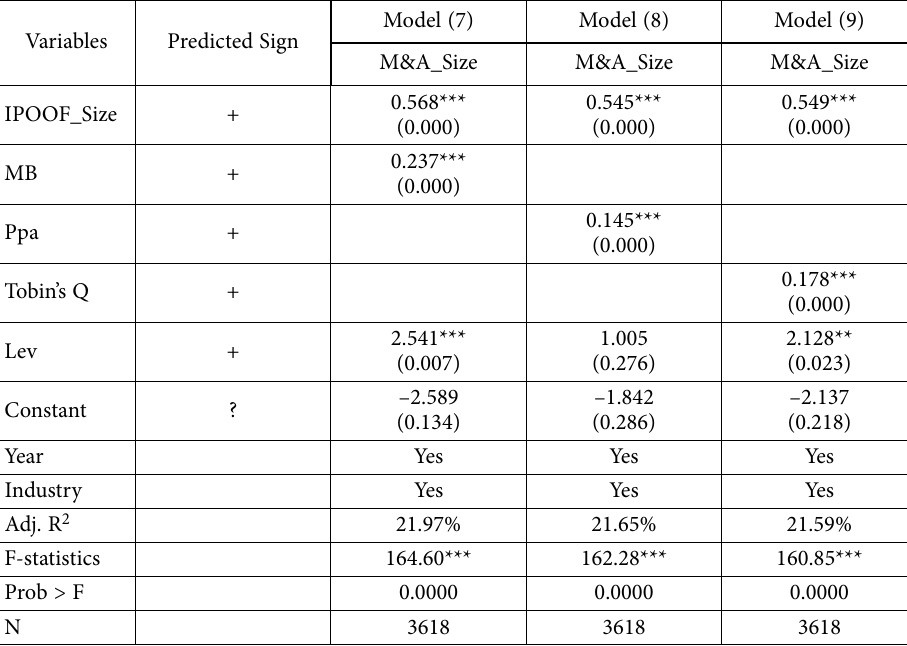
Table 11. IPO over-financing, market overvaluation and the size of transactions